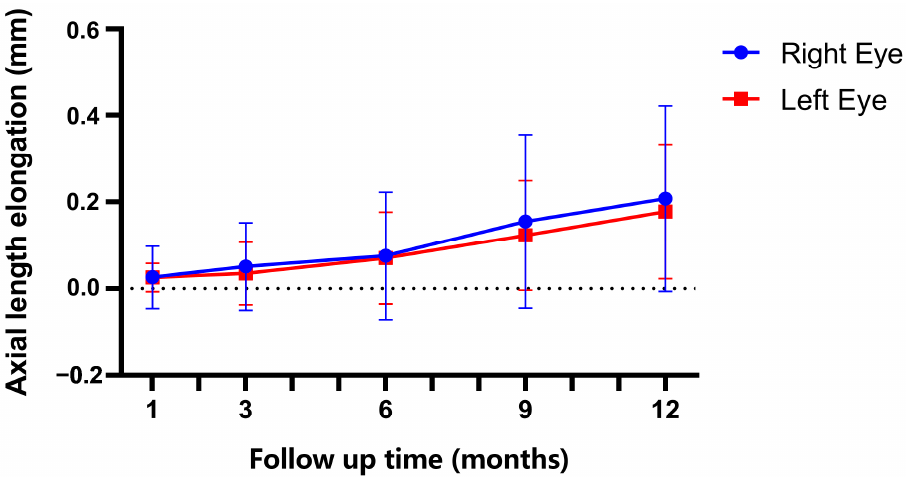
Figure 3. The changes in axial length in both eyes over the one-year orthokeratology lens wearing. Bars represent mean; error bars stand for the standard deviation of the mean.